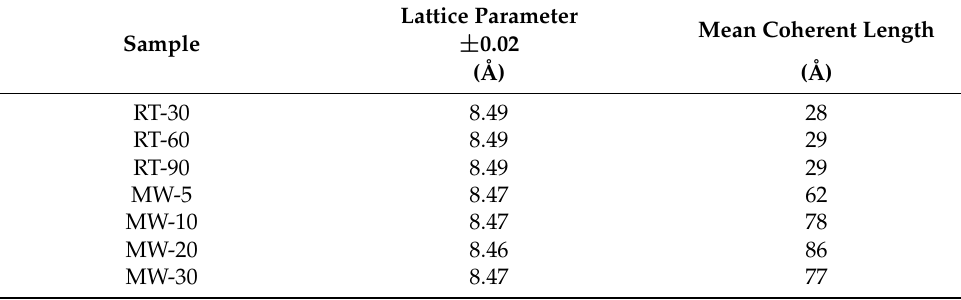
Figure 2. XRD patterns of zinc ferrite nanoparticles prepared by the microwave-enhanced approach (samples MW-5, MW-10, MW-20 and MW-30) in the 2 θ range from 10° to 100°. The data were normalized with respect to the measurement time per step. Table 2. Quantification of XRD patterns of zinc ferrite